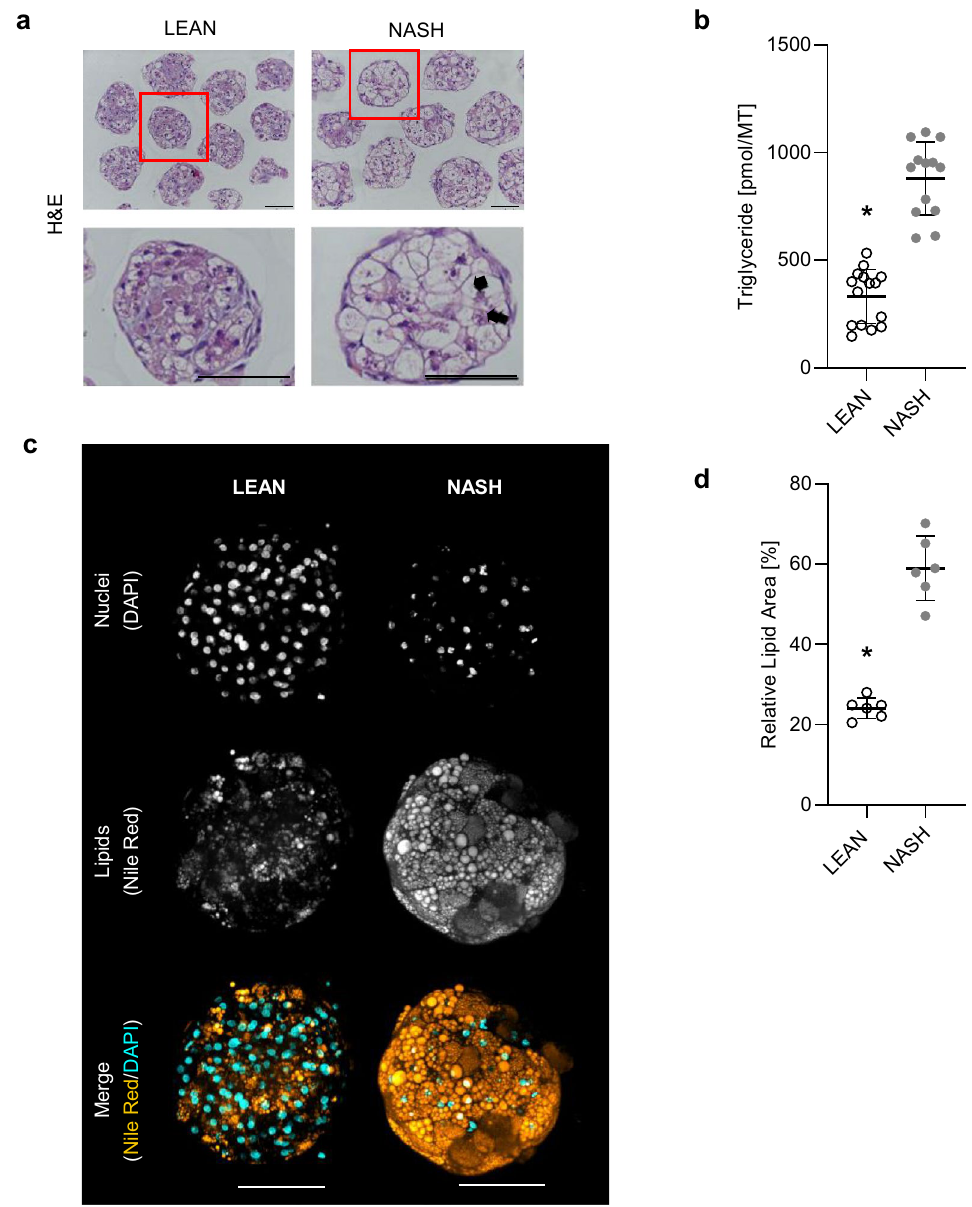
Figure 2. Steatosis-like phenotype and lipid accumulation in NASH-treated hLiMTs. ( a ) H&E staining demonstrating increased accumulation of lipids within the NASH hLiMTs compared to LEAN control hLiMTs. Ballooning of hepatocytes with displaced nuclei (arrows). Scale bars indicate 100 μm. ( b ) A significant increase (*p < 0.05) of tissue TG levels in NASH vs. LEAN control-treated hLiMTs, confirming the steatosis-like phenotype. TG data is a mean of three independent experiments (LEAN n = 15, NASH n = 13). ( c ) Intracellular lipid accumulation was assessed by Nile Red whole-mount staining and represented as maximal intensity projections. Increased intracellular lipid accumulation, as well as increased micro-vesicular (small lipid droplets) and macro-vesicular (big lipids droplets) steatosis was detectable in NASH vs. LEAN control hLiMTs. Scale bars indicate 100 μm. ( d ) High content image-based quantification of lipid content demonstrated significant increase of lipids in NASH treated hLiMTs compared to control hLiMTs (*p <